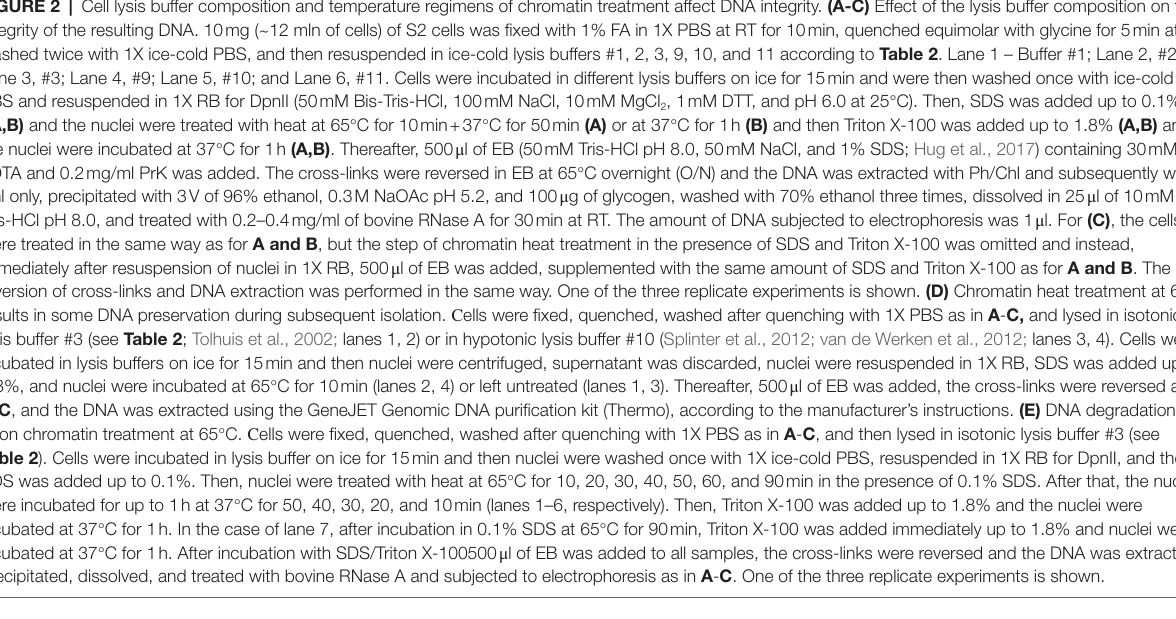
divided into the supernatant and pellet fractions and the supernatant fractions were analyzed. Release of the genomic DNA from nuclei into the supernatant (as well as a release of processed ribosomal RNA) was clearly detectable in 8 out